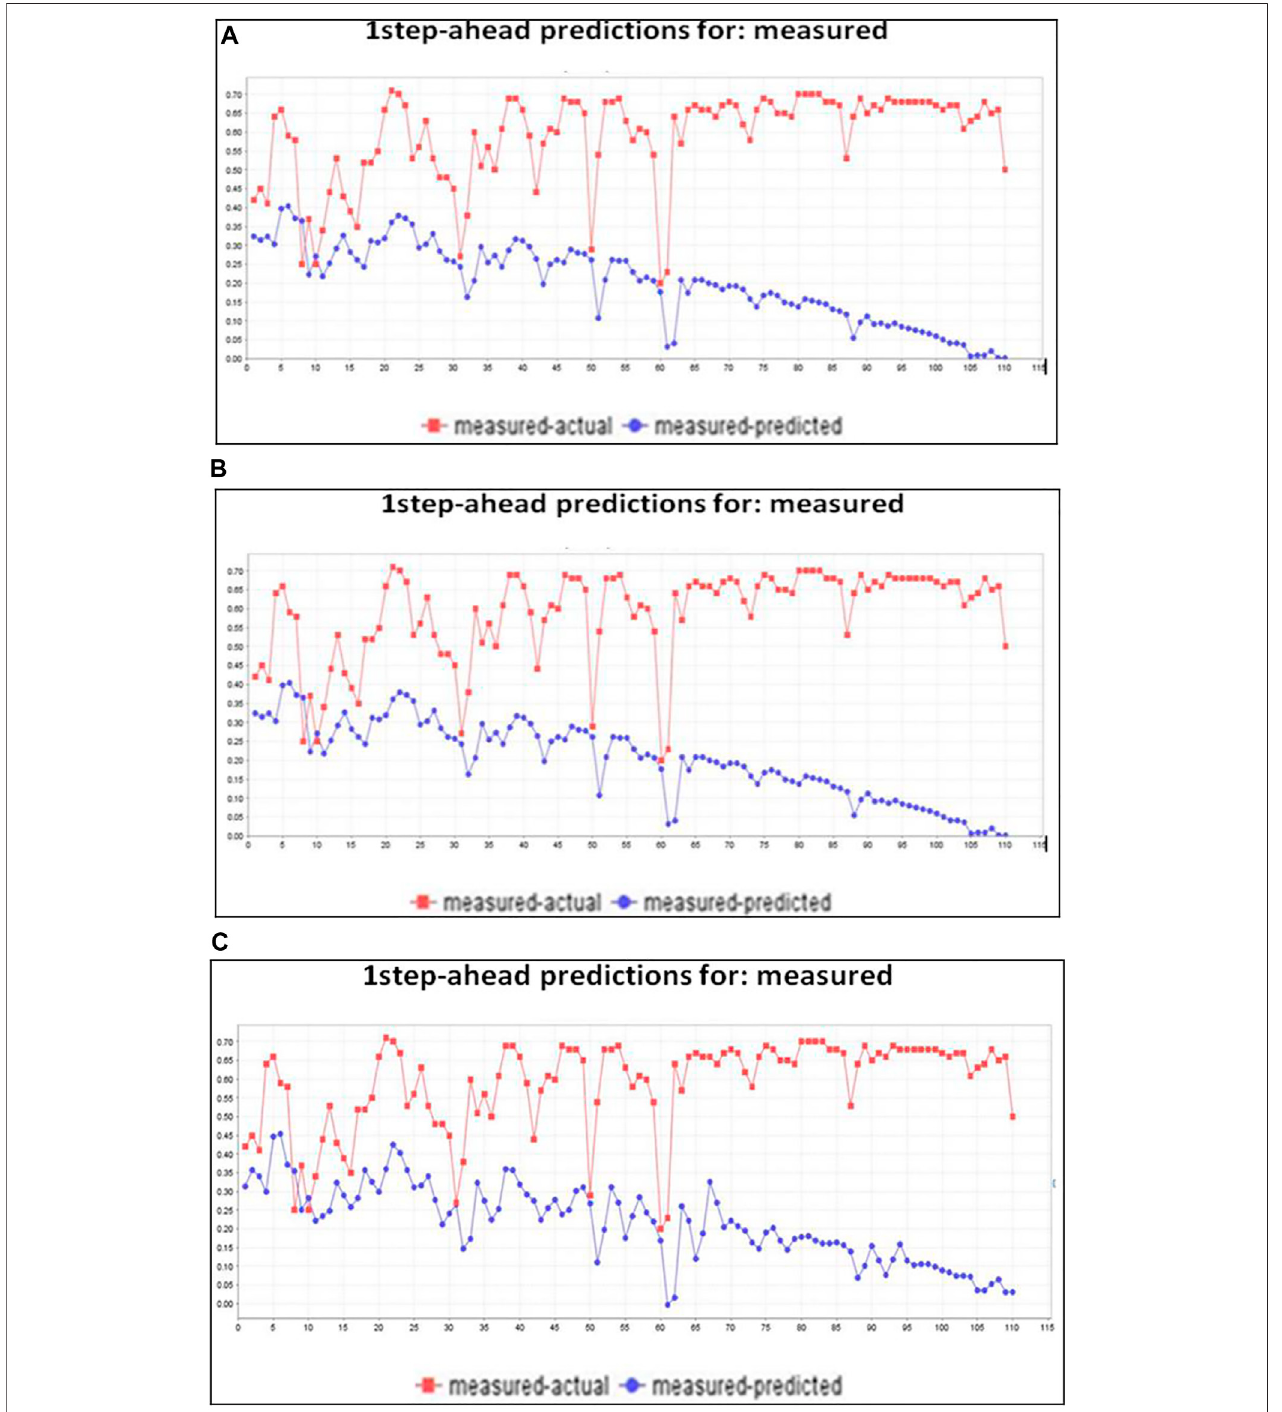
FIGURE 10 | (A) Prediction of solar radiation for the city of Bhubaneswar. (B) Solar radiation forecasting of Kolkata. (C) Prediction of solar radiation for the city of Visakhapatnam.